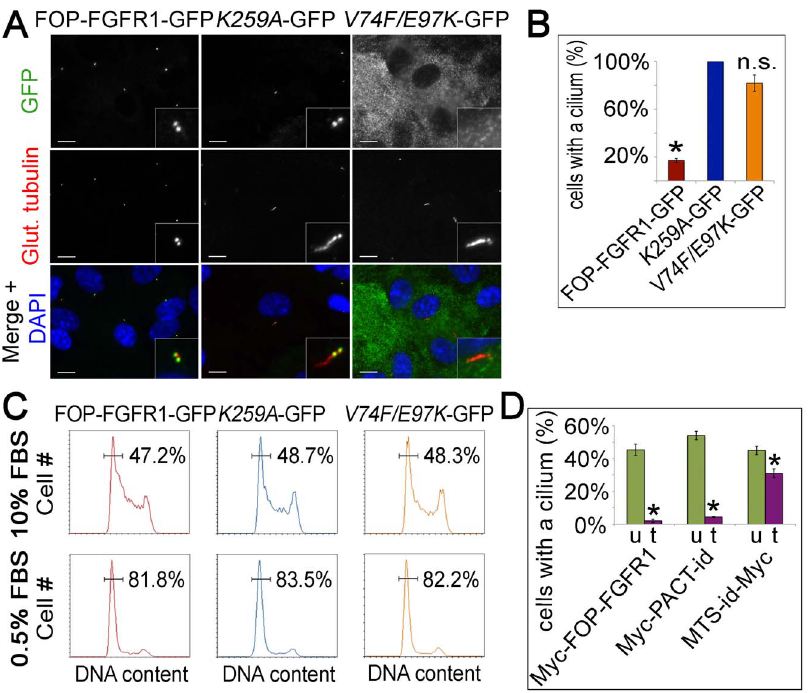
Figure 4. MPN fusion expression causes a decrease in ciliogenesis. ( A ) RPE-1 cells stably expressing FOP-FGFR1-GFP, Myc-FOP-FGFR1 K259A - GFP, or Myc-FOP-FGFR1 V74F/E97K -GFP, serum-starved for 48 h, fixed, and stained with antibodies against GFP (green) and glutamylated-tubulin (red). DNA is stained using DAPI (blue). Scale bars: 10 m m; insets: 5 6 magnification. ( B ) Graph showing percent of FOP-FGFR1-GFP and mutant expressing cells that form a primary cilium normalized to FOP-FGFR1 K259A -GFP. Bars represent mean of three independent trials 6 SEM. *p , 0.05, n.s. p . 0.05. ( C ) Percentage of GFP-positive cells with G 0 /G 1 DNA content following 48 h incubation in complete or low serum medium. N=10,000 cells each. ( D ) Graph showing percent of transfected (t) Myc-FOP-FGFR1, Myc-PACT-idFGFR1, and MTS-idFGFR1-Myc expressing cells that form a primary cilium compared to neighboring untransfected (u) cells following 48 h incubation in low serum medium containing dimerization ligand. Bars represent mean of technical triplicates 6 SEM. *p ,